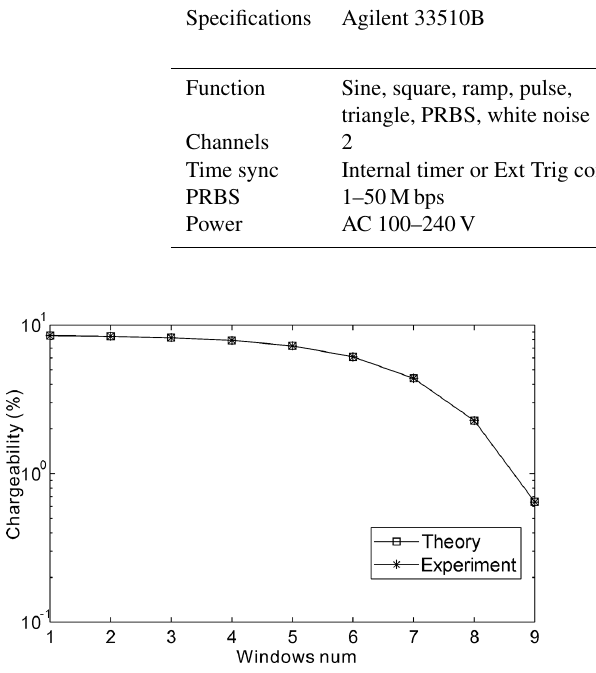
Figure 11. Comparison between the calculated results and the the- oretical simulation results for TDIP mode.